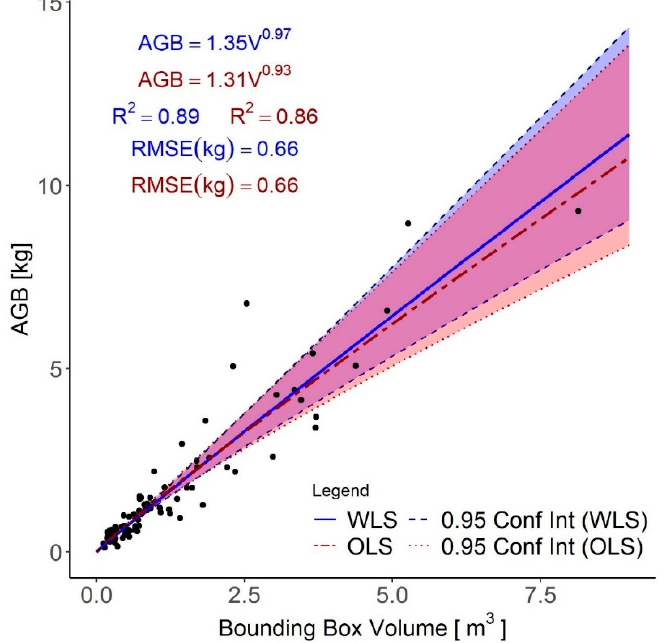
Figure 4. Comparison of models fitted using the weighted least squares (WLS) method (blue solid line) and the ordinary least squares (OLS) method (red dash-dotted line). Both models use the bounding box volume of individual tree point clouds as a predictor, but the WLS model gives more weight to the trees with higher above ground biomass. The dashed and dotted lines show the 0.95 confidence intervals for the WLS and OLS models, respectively.